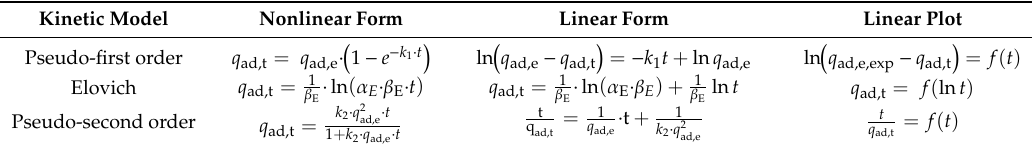
Table 2. Kinetic models for